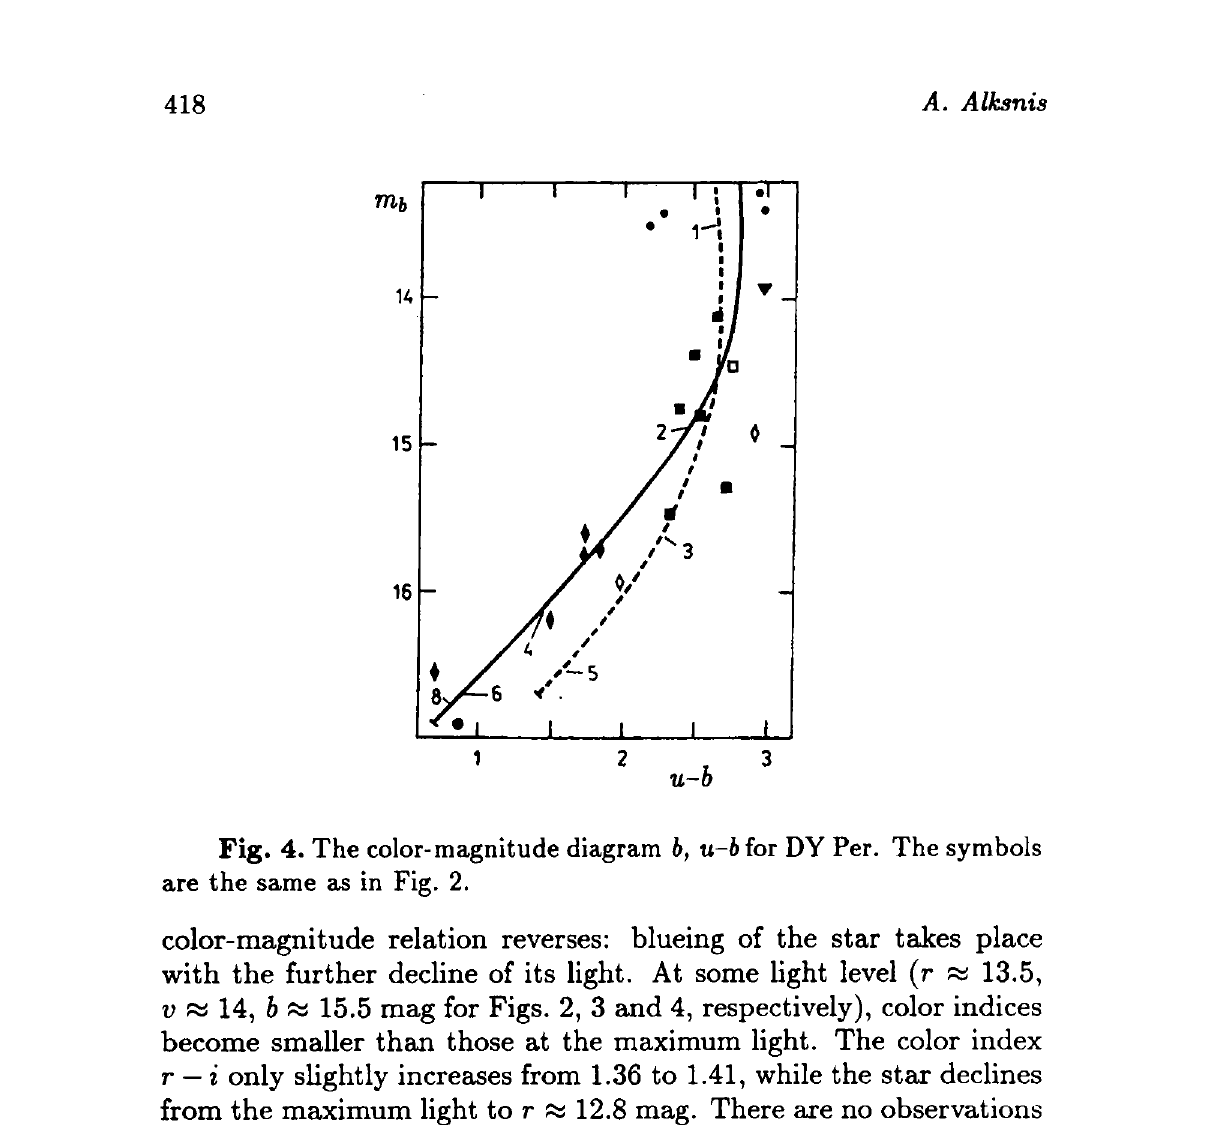
Fig. 4. The color-magnitude diagram b, u-ôfor DY Per. The symbols are the same as in Fig.